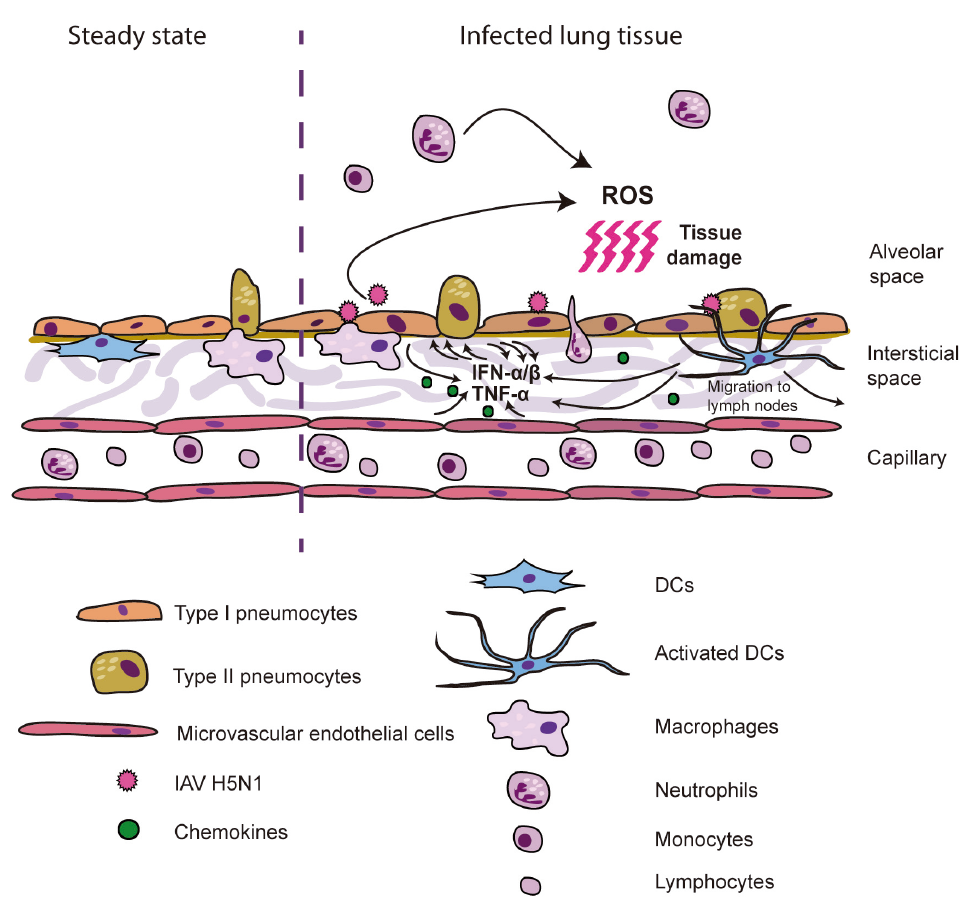
Figure 1. Model for ARDS induction by H5N1 IAV. H5N1 viruses infect epithelial, endothelial and inmmune cells, which upon recognition of viral PAMPs produce high levels of cytokines and chemokines. Those induce increased production of cytokines by resident cells, as well as recruitment of neutrophils, monocytes and macrophages, responsible for the oxidative stress upon production of ROS, causing severe cell and tissue